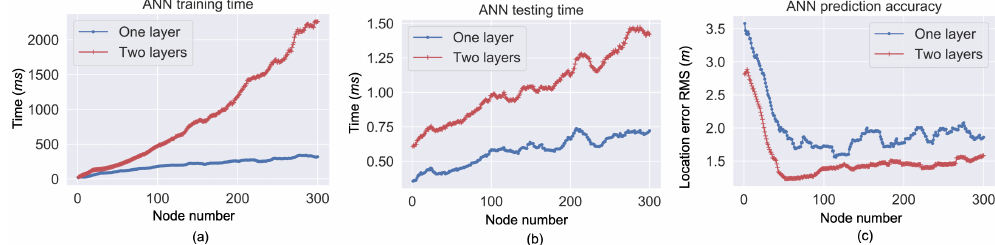
Figure 9. Processing time for ANN training ( a ) and testing ( b ), as well as RMS of differences between ANN-predicted location errors and actual ones ( c